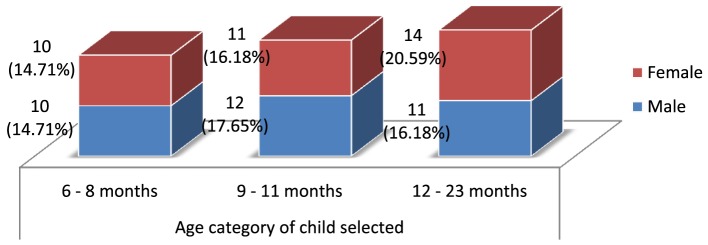
Age distribution and gender composition of the children selected for the study.